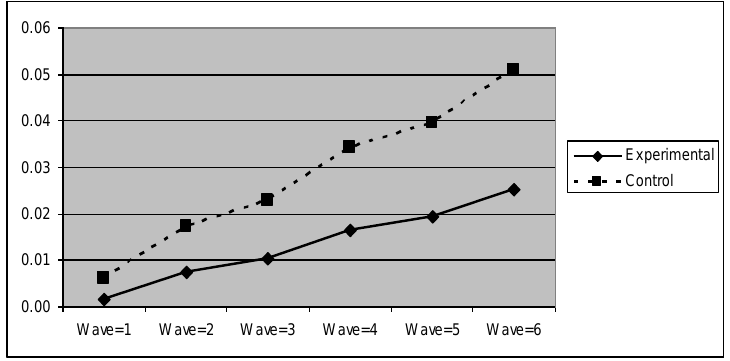
FIGURE 5 . Growth trajectories of the experimental group (participants who joined the Tier 1 Program only) and control group using the item score of psychotropic drug use as the outcome indicator.